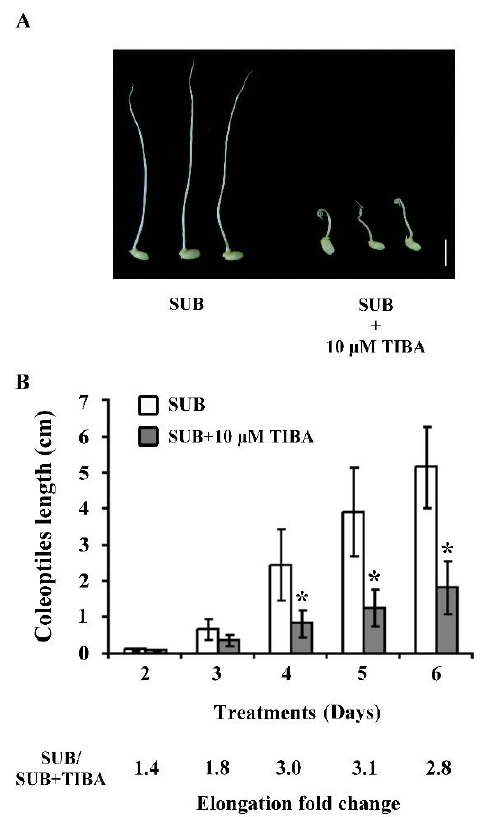
Figure 1. The effects of auxin polar transport inhibitor 2,3,5-triiodobenzoic acid (TIBA) on submerged rice coleoptiles. ( A ) Rice seeds after submergence (SUB) and submergence combined with 10 µM TIBA (SUB + TIBA) for five days. ( B ) Lengths of rice coleoptiles after SUB and SUB + TIBA treatment for 2–6 days. Bar = 1 cm. Data expressed as average values ± standard deviations from six biologically independent experiments. * p < 0.05 versus value in submergence treatment (Student’s t -test).